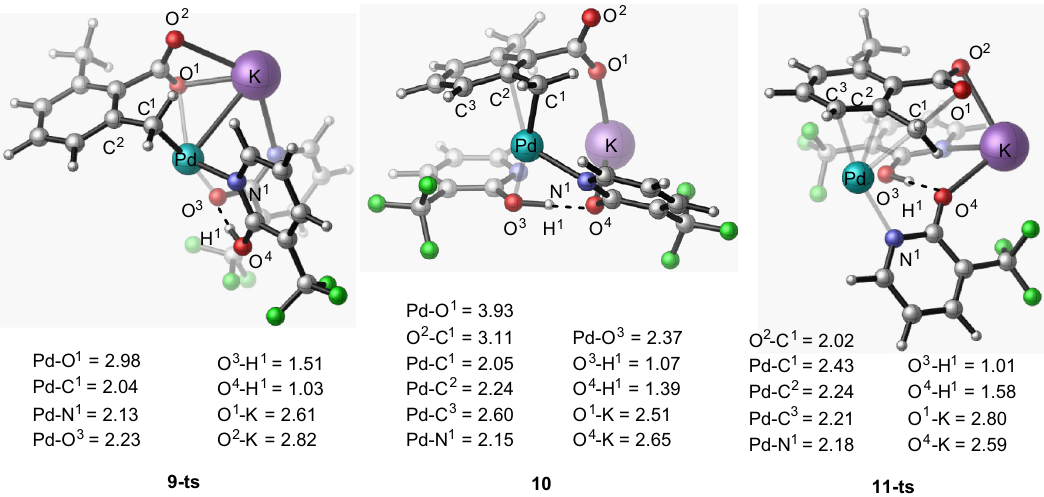
Fig. 4 The calculated geometry structures of the critical transition states and intermediates. The optimized structures of 9-ts , 10 , and 11-ts along with their important geometry parameters (in